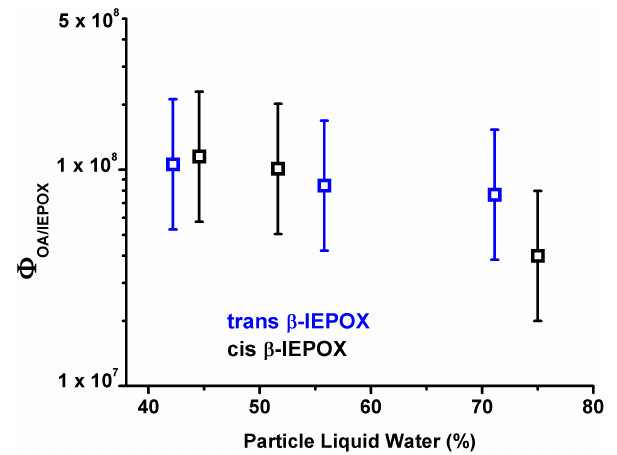
Fig. 2. Reactive partitioning coefficients ( 8 OA/IEPOX ) during the gas-phase IEPOX injection phase for the trans and cis isomers as a function of the particle liquid water concentration. Error bars indi- cate experimental uncertainty as described in the